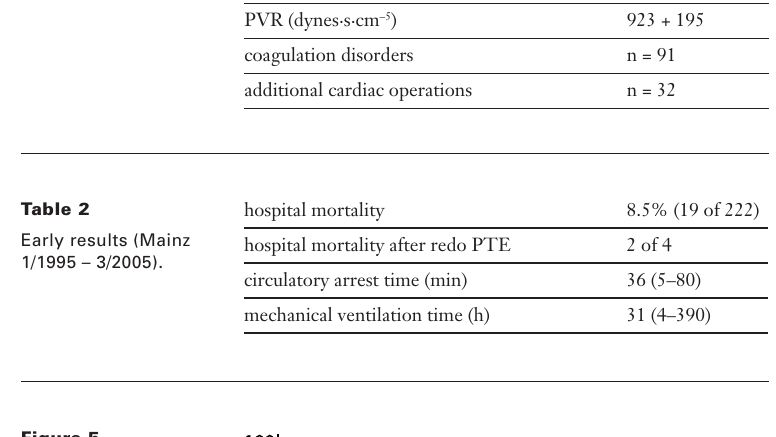
Long-term survival after thromboen- darterectomy is excellent (Mainz, 1989–2001, n =